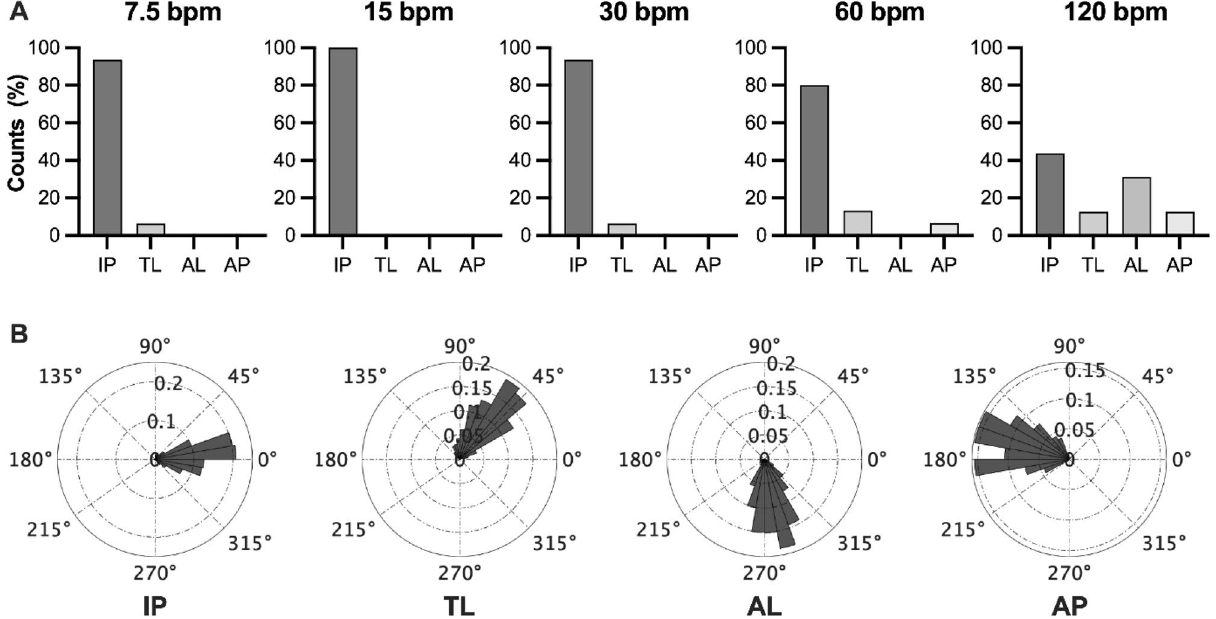
Figure 3. Frequency of particular thoraco-abdominal coordination patterns identified by the phase relation analysis, and a representative example of a participant’s relative phase histogram for each pattern. IP in-phase pattern, TL thoracic-leading pattern, AL abdominal-leading pattern, AP anti-phase pattern.